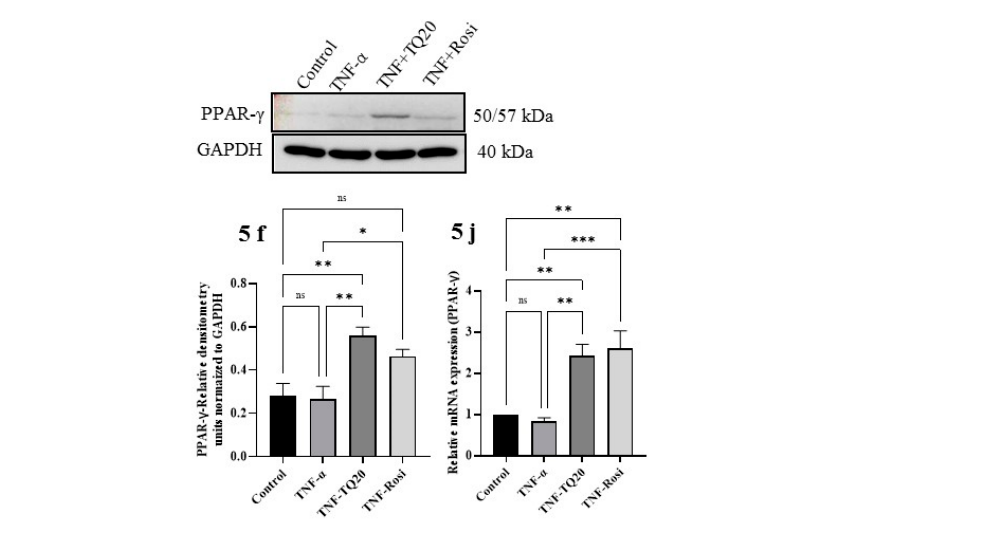
Figure 6. Effect of TQ on PPRE-pNL1.3[secNluc] plasmid containing PPAR- γ transcription factor promoter activity . The full-length sequence of PPAR- γ was cloned into PPRE-pNL1.3[secNluc] plasmid transfected using lipofectamine LTX in HT-29 cells. Luciferase expression at 24 and 48 h was determined in 50 μ L supernatant culture media luminometrically. TQ treatment (20 μ M) sig- nificantly increased luciferase expression in PPRE-pNL1.3 transfected HT-29 cells time-de- pendently (24 h ( a ), 48 h ( b )). Rosiglitazone (PPAR- γ agonist, 10 μ M) used as a positive control. The luciferase expression was compared to non-transfected controls. n = 4 separate experiments used for obtaining the data for PPAR- γ promoter activity studies. The data expressed as means ± SEM. ≤ 0.05 considered statistically significant. **** p < 0.0001 , *** p < 0.001 , ** p < 0.01 , and * p < 0.05 . (NS) not significant.